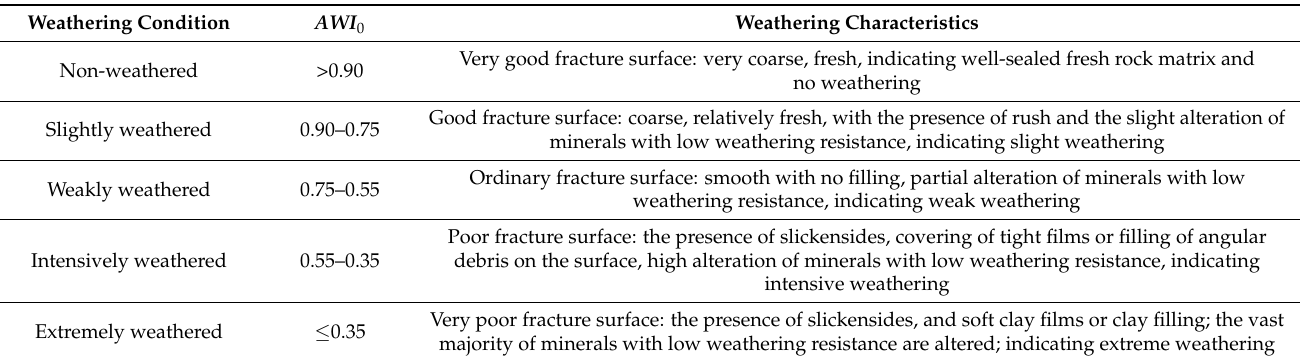
Table 3. Representation of the rock mass weathering characteristics by AWI .